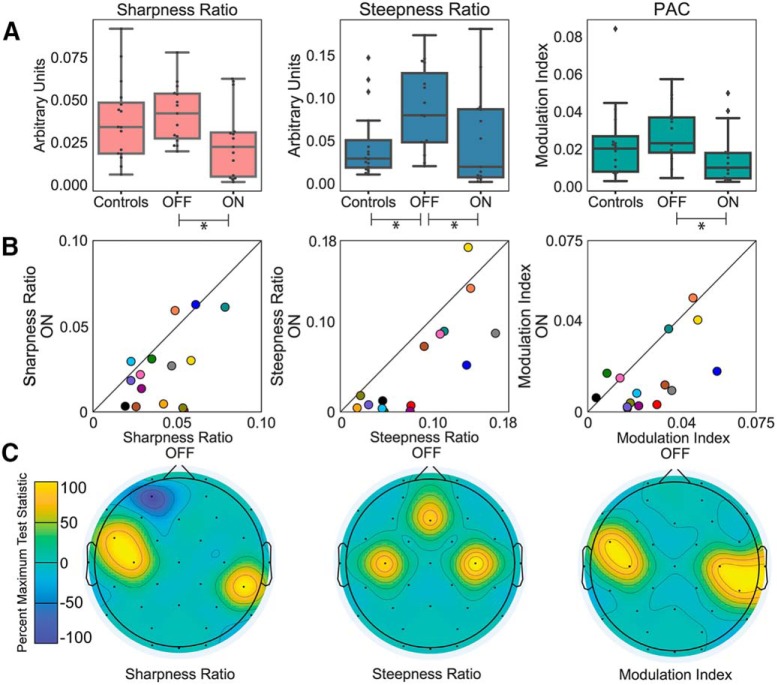
Sharpness ratio, steepness ratio, and PAC all decreased with medication in PD patients. A, Box plots of each measure for patients off medication, on medication, and control participants. Asterisk represents FDR corrected significance at p < 0.05. Note that the on versus off medication comparison was a paired comparison (Wilcoxon sign rank) whereas the off medication versus control comparison was unpaired (Wilcoxon rank sum). B, Individual data for each measure and each patient on and off medications. Each color corresponds to a different participant. Diagonal lines represent unity. C, Scalp topography for on versus off medication for each measure. For each electrode, test statistics below the critical value, indicating significance, were set to zero. Test statistics above the critical value were rescaled and normalized to the percentage of the most significant test statistic, such that 100 would reflect the most significant test statistic.